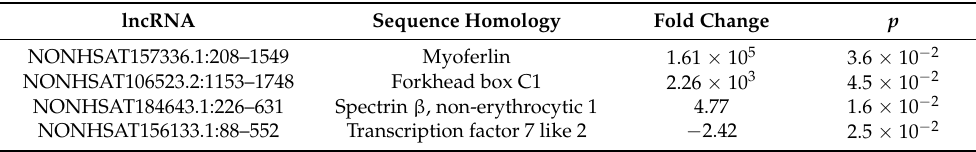
Table 8. Intraocular Pressure-Associated Genes with Sequence Homology to Differentially Expressed Long Non-Coding RNAs (lncRNAs) in Cyclically Stretched Human Trabecular Meshwork